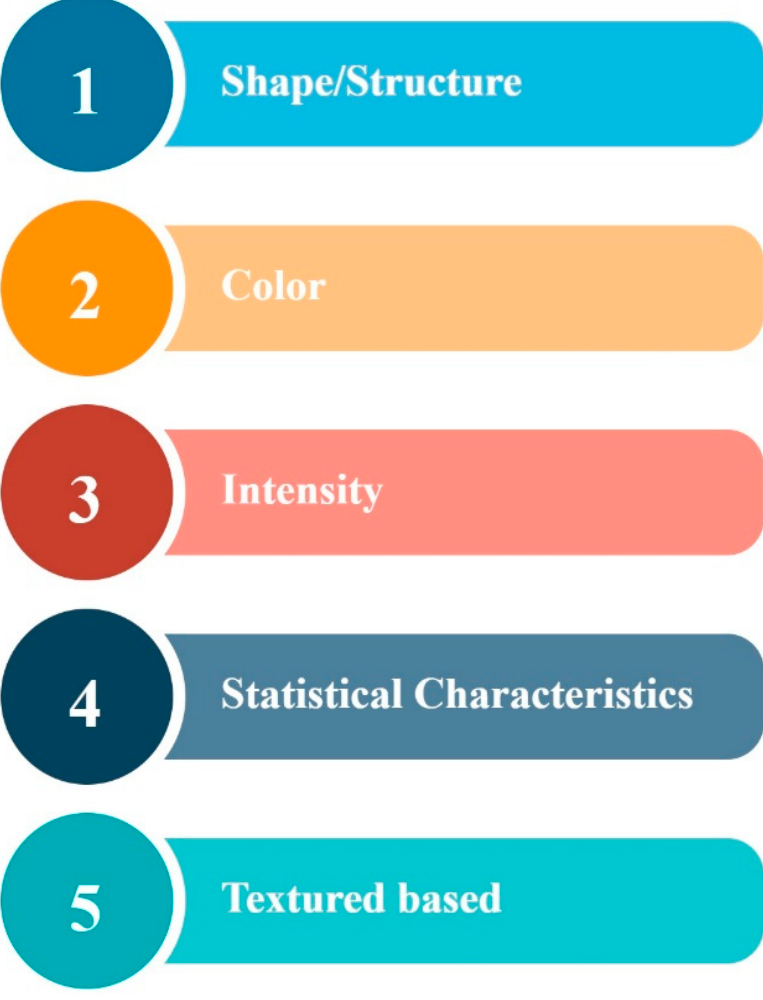
Figure 12. Feature extraction parameters. (a) Characteristics based on shape and structure: The shape and size of various DR lesions, such as hard and soft exudates, hemorrhages, and microaneurysms, are among these characteristics. For example, Zhou and Wu [94] used shape-based criteria to detect microaneurysms: area and perimeter, axis length, circularity, and compactness. (b) Features based on RGB (color): These characteristics are based on the image’s red, green, and blue color planes. For example, authors Jaya and Dheeba [95] employed color fundus images to detect hard exudates and used four color-based characteristics. They used RGB color space to build color